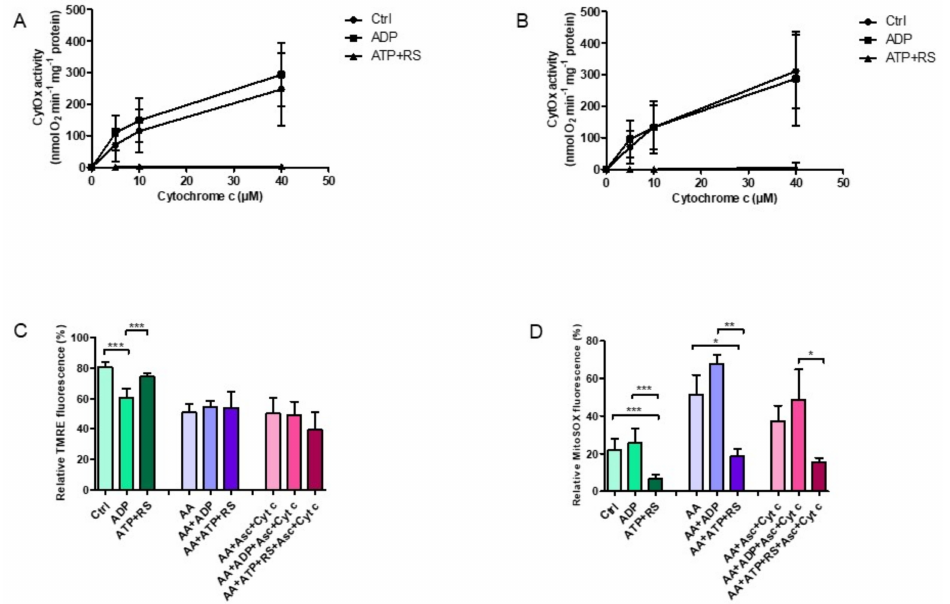
Figure 4. Effect of antimycin A on CytOx kinetics, mitochondrial membrane potential and ROS production. Samples were prepared by adding 0.054 mg/mL ± 0.004 freshly isolated rat